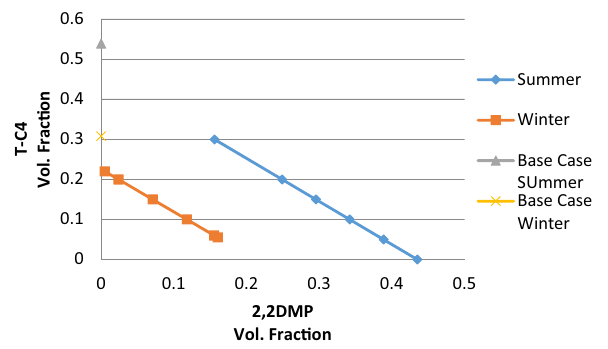
Fig. 39 Effect of adding 2,2DMP and 20 vol% DME on LPG T-C4